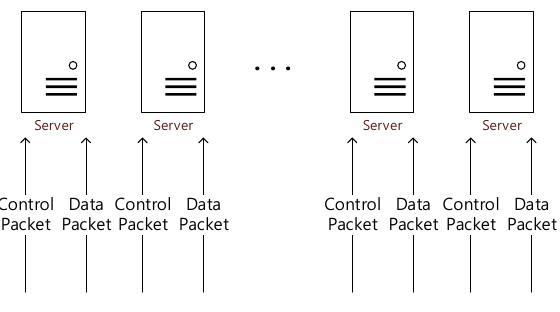
Figure 9. Example of a dual environment.